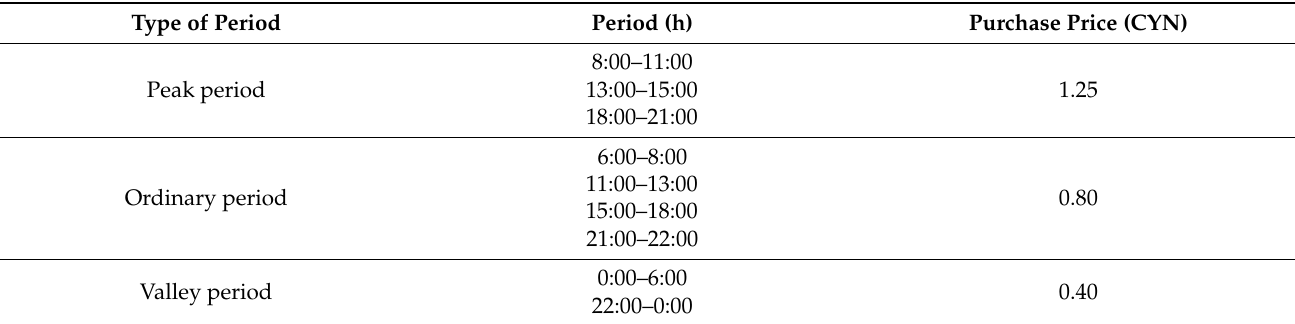
Table 4. Electricity purchase price of the MREPS from the main